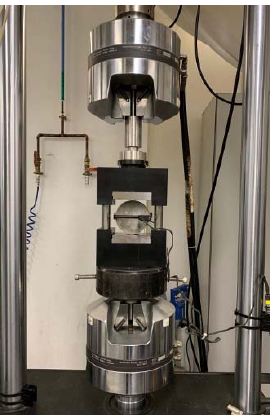
Figure 2. Splitting tension setup used to fracture ECC disk-shaped specimens.